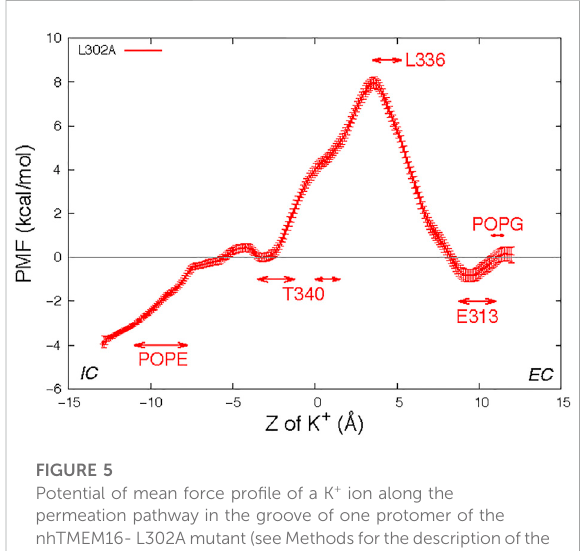
FIGURE 5 Potential of mean force pro fi le of a K + ion along the permeation pathway in the groove of one protomer of the nhTMEM16- L302Amutant(seeMethodsforthedescriptionofthe error bar calculations). Z = 0 is set to be the Z position of the T381 C α atom of this subunit. As in Figure 3, the “ critical interaction ” ranges are marked by horizontal double